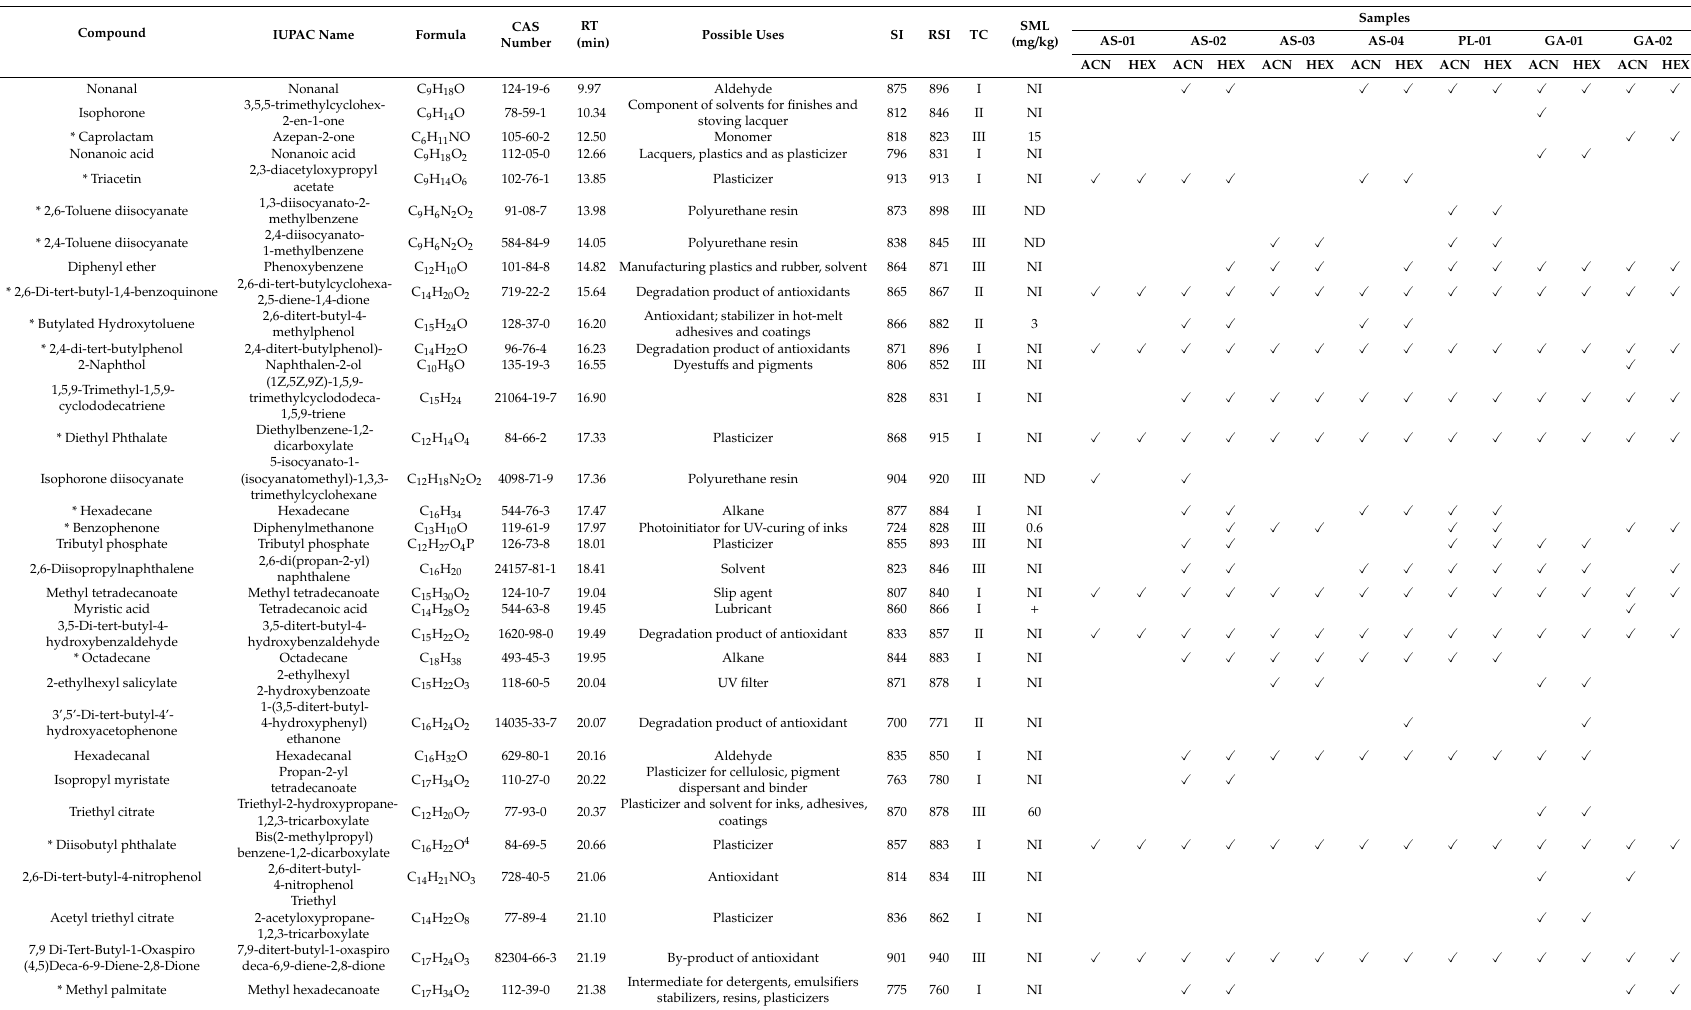
Table 3. Compounds identified in the studied plastic packaging